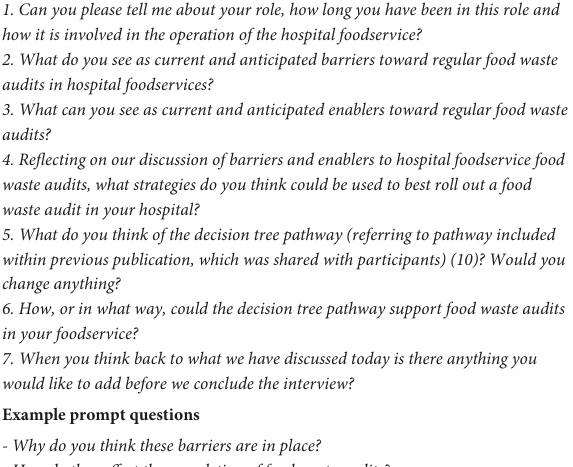
TABLE 1 Semi-structured interview protocol to explore staff involved in the operation of hospital foodservices perspectives on how an evidenced based consensus pathway food waste audit tool is perceived to translate into practice, and to determine the factors that influence the completion of food and food-related waste audits within this